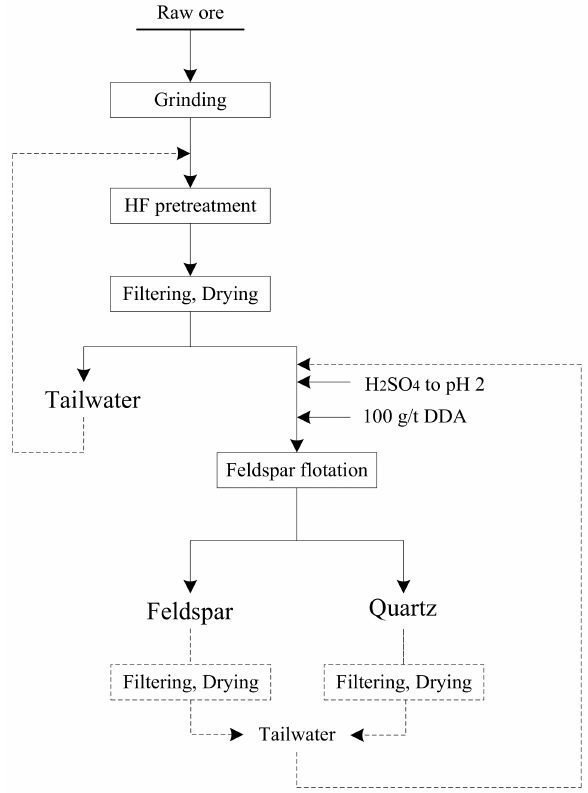
Figure 10. Proposed process for effective separation of quartz and feldspar while recycling the tailwater from